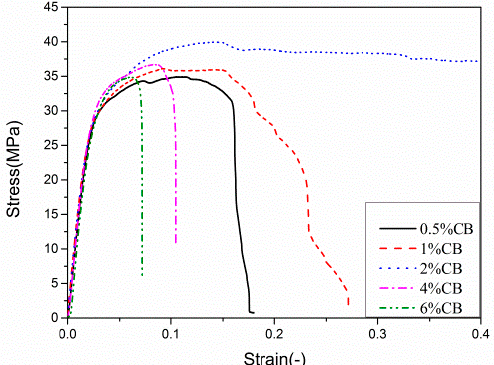
Figure 4. Stress–strain curves of carbon black (CB)/polyvinylidene fluoride (PVDF) composites.